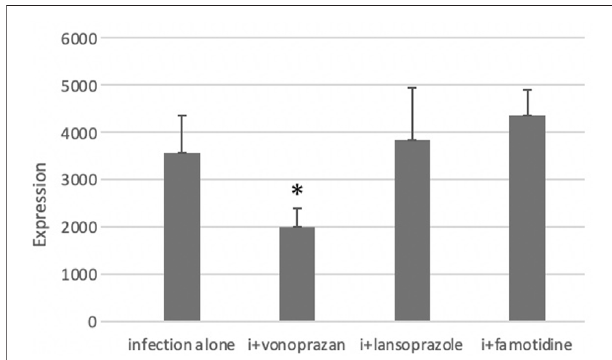
FIGURE 6 | Effect of acid suppressants on the NHPH number by PCR. PCR analysis showed signi fi cant difference between infection alone and administered agents (F = 5.33 and p = 0.008 by one-way ANOVA). Post hoc analyses (Bonferroni correction) revealed that the infection-alone group is signi fi cantly larger than the infection + vonoprazan group (* p = 0.008). Decrease in NHPH in the vonoprazan-treated mice, but signi fi cant interaction was found between infection and administered agents in NHPHs (F = 7.17; p =